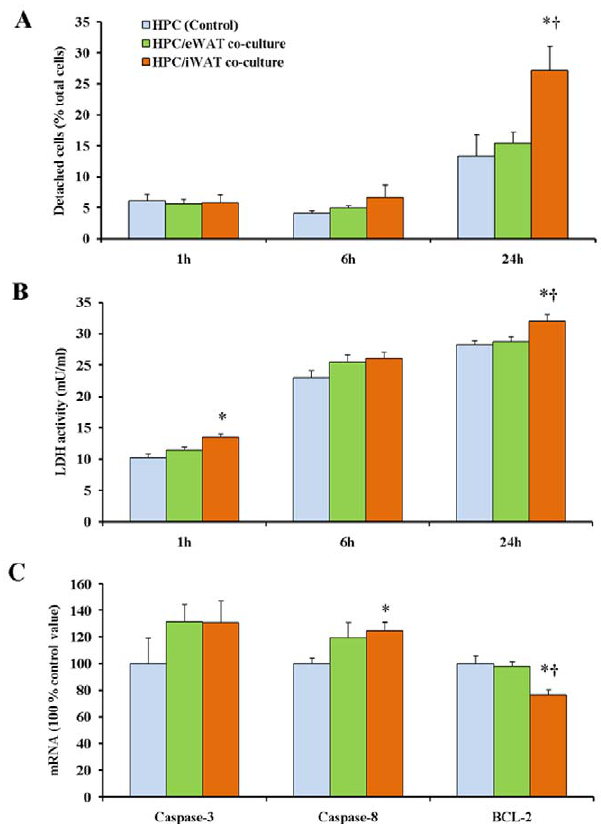
Figure 5. Cytotoxic properties of rat hepatocytes (HPC) co- cultured with adipose tissue explants from epididymal adipose tissue (eWAT) and inguinal adipose tissue (iWAT). A: Detached HPCs in HPC-fat pads co-culture after 24 h. B: Activity of lactate dehydrogenase (LDH) released in co-culture medium. C: Expression levels of apoptosis marker genes in HPCs. b -actin was used as a reference gene. * and **, P , 0.05 and P , 0.01 vs control value, respectively. { , P , 0.05 vs eWAT co-culture group value.